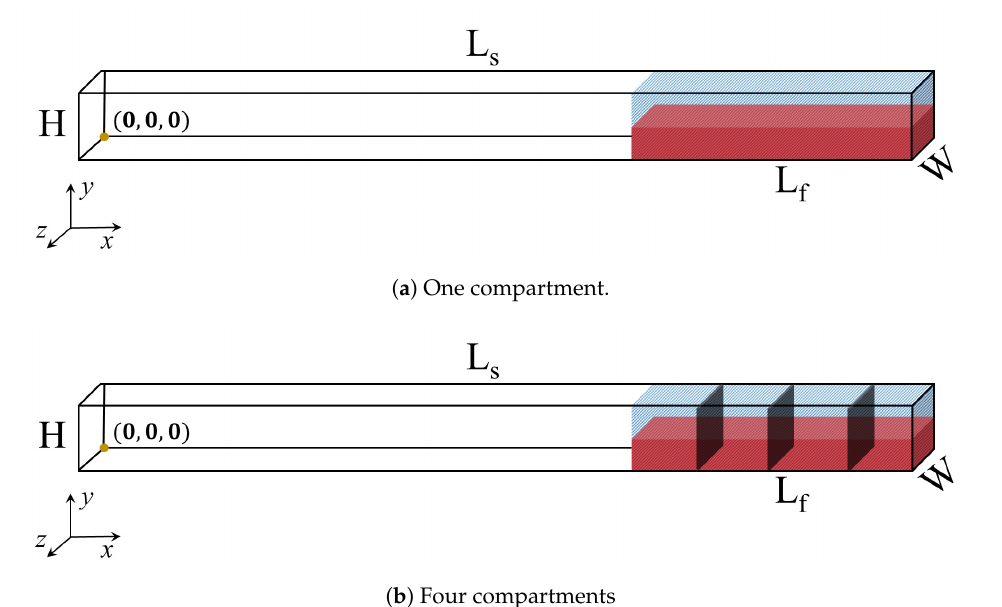
Figure 1. Schematic of the simplified elastic aircraft-wing-like structure consisting of a hollow cantilevered steel beam with a sloshing water